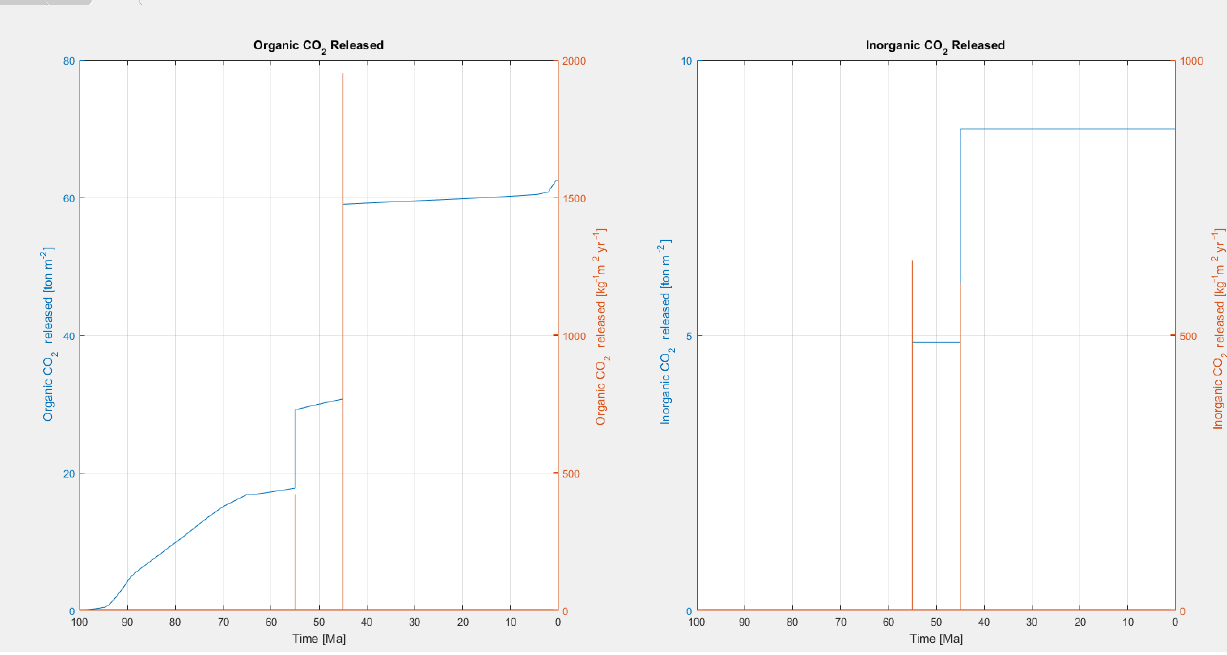
Figure 4. Snapshot of the release tab generated for a hypothetical sedimentary column with two sill intrusions and three eroded layers. Right-clicking any curve allows the user to copy curve